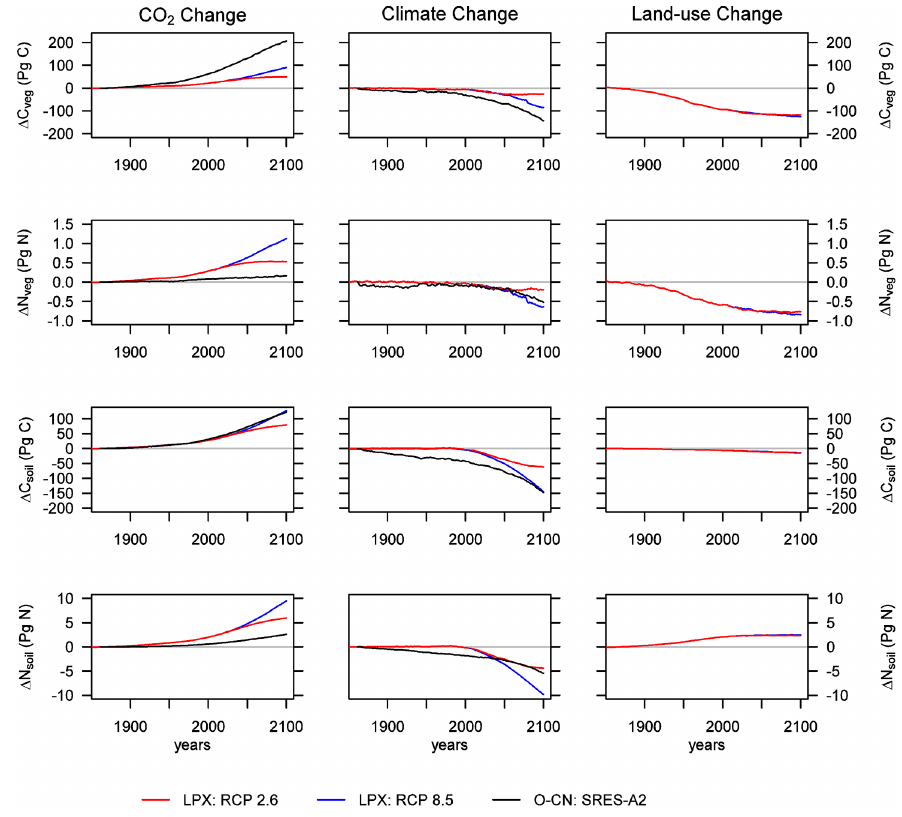
Figure 13. Responses of the terrestrial vegetation and soil C and N pools to projected changes of the atmospheric CO 2 burden, climate, and land use between 1860 and 2100, as simulated by two global terrestrial biosphere models (LPX, Stocker et al., 2013; and O–CN, Zaehle et al., 2010a). The LPX simulations are based on the climate change projections of HadGEM2-ES model using atmospheric greenhouse gas and land-use forcing for the RCP2.6 and 8.5 scenarios. The O–CN simulations have been driven by climate change projections of the IPSL-CM4 model using the atmospheric greenhouse gas forcing of the SRES-A2 scenario.